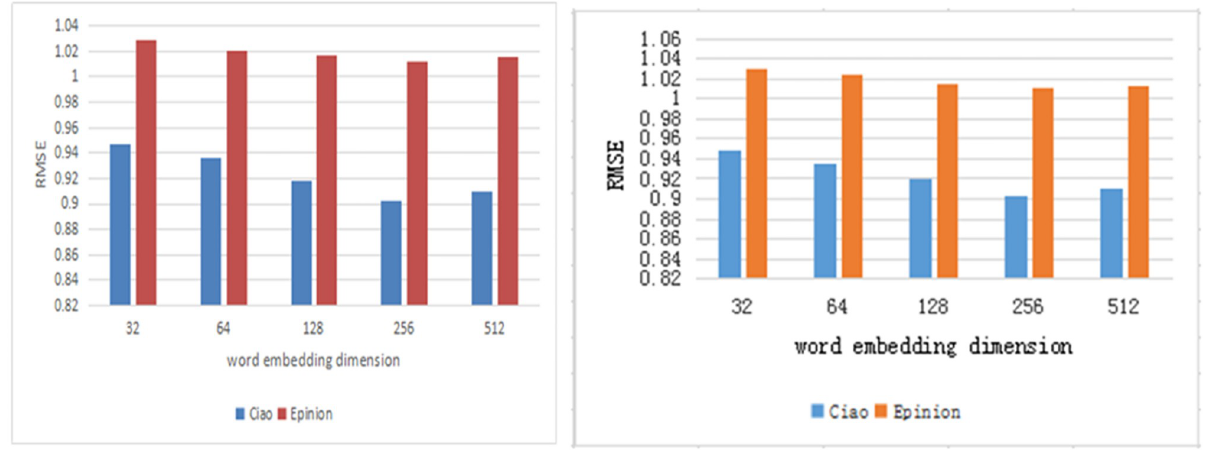
Fig 4. Validation RMSE as a result of varying d w , d z .